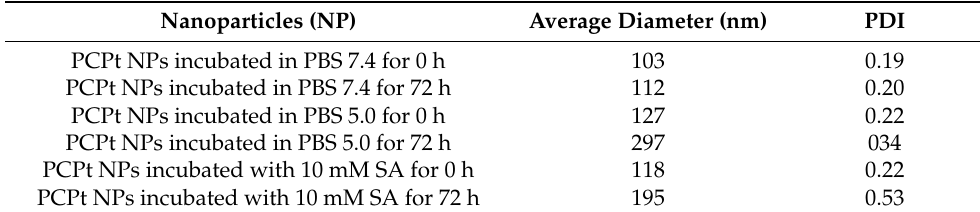
Figure 2. ( a ) 1 H NMR spectrum of PCPt (400 M, D 2 O), ( b ) intensity ratio (I 336 /I 333 ) in the fluorescence spectra of pyrene as a function of PCPt concentrations in aqueous solution, ( c ) particle size distribution of PCPt NPs, and ( d ) TEM morphology of PCPt NPs (scale bar: 500 nm). Table 2. Nanoparticle size (average diameter) and polydispersity index (PDI) determined by dynamic light scattering